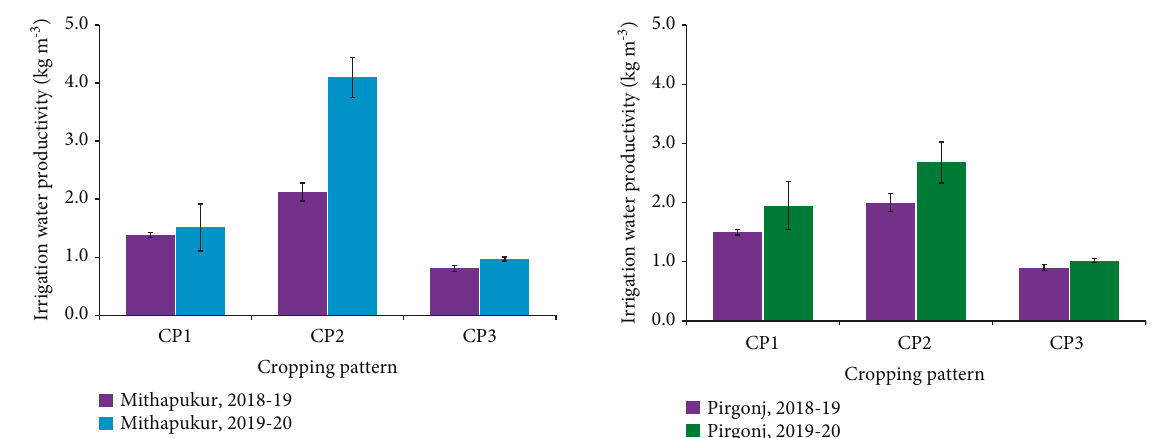
Figure 4: Irrigation water productivity of different cropping patterns at Mithapukur and Pirganj of Rangpur during 2018–2019 and 2019–2020. Error bar indicates standard error. Table 5: Gross margin (GR), total variable cost (TVC), and gross margin (GM) of different cropping patterns (CP1: T. Aman-Mustard- Boro, CP2: T. Aman-Potato-Boro, CP3: T. Aman-Fallow-Boro) at Rangpur during 2018–2019. Cropping patterns